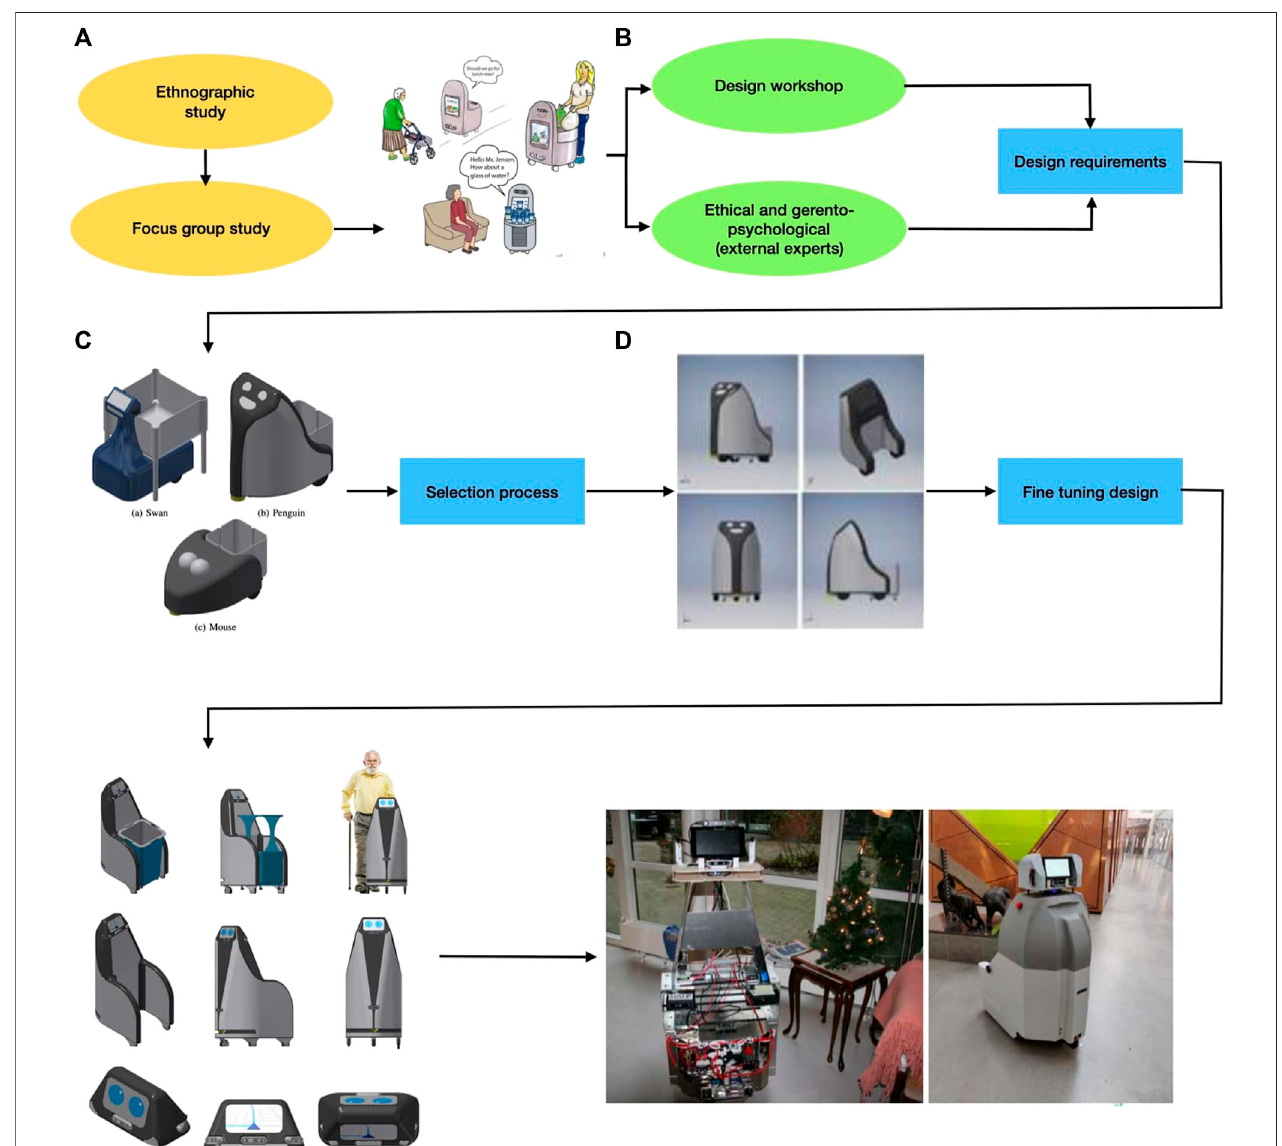
FIGURE 8 | Overview of the SMOOTH design process: (A) ethnographic observation, (B) design workshop, (C) initial conceptualization, and (D) fi ne tuning.